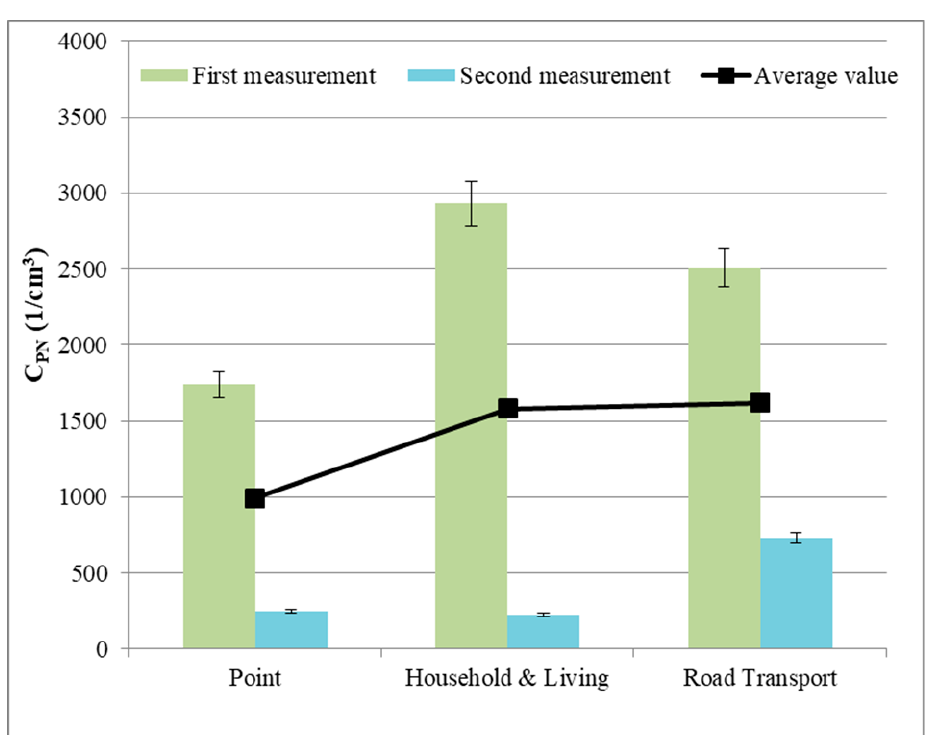
Figure 11. Number of PM10 per cm 3 in Poznan (own study).